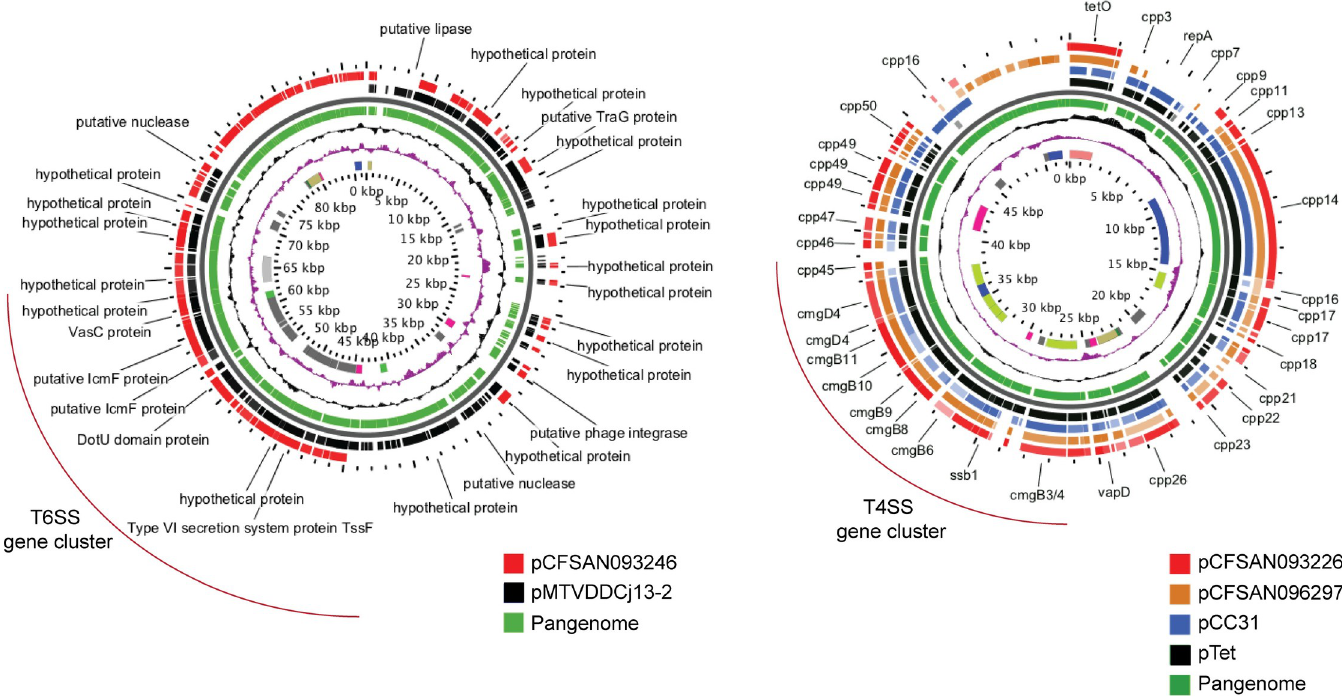
Fig 6. Comparative genomic analysis of plasmids encoding T6SS (A) and T4SS (B) gene clusters. Pangenome BLAST analysis was performed using the Gview server. T6SS and T4SS gene clusters are highlighted in red brackets.